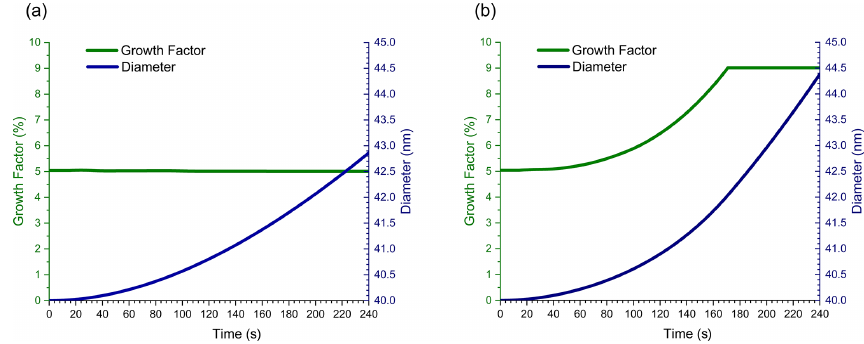
Figure 2. Growth factor and particle diameter vs. time for 40nm diameter ammonium sulfate seed particles travelling through the flow tube, growing by (a) condensation of NVOCs and partitioning of SVOC s alone, and (b) with SVOC 0 dimer formation included.